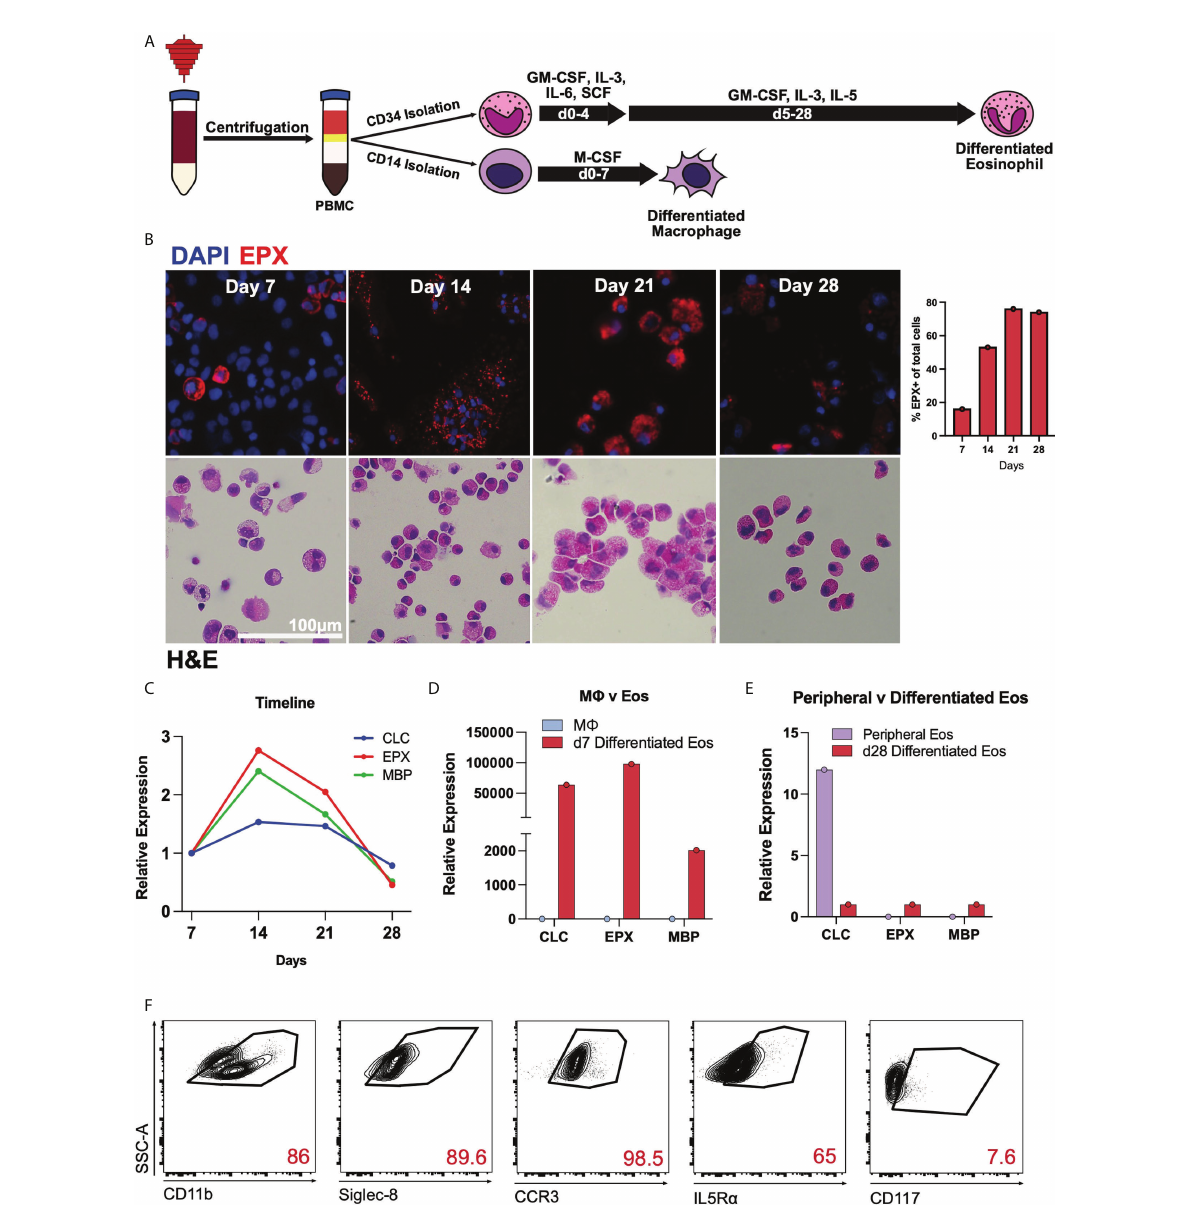
FIGURE 1 Human CD34+ hematopoietic stem cells mature into differentiated eosinophils. (A) Schema for differentiating eosinophis and macrophages from apheresis cones. (B) DAPI, EPX (above) and H&E staining of CD34+ cells during differentiation on days 7, 14, 21, and 28. Percent EPX+ cells of total cells shown graphically. (C) Expression of CLC, EPX , and MBP transcripts during differentiation relative to day 7 (baseline). (D) Expression levels of CLC, EPX , and MBP on day 7, relative to CD14+ cells. (E) Expression levels of CLC , EPX and MBP on mature peripheral eosinophils and day 28 differentiated eosinophils. (F) Flow cytometry of day 21 differentiated eosinophils for canonical eosinophil